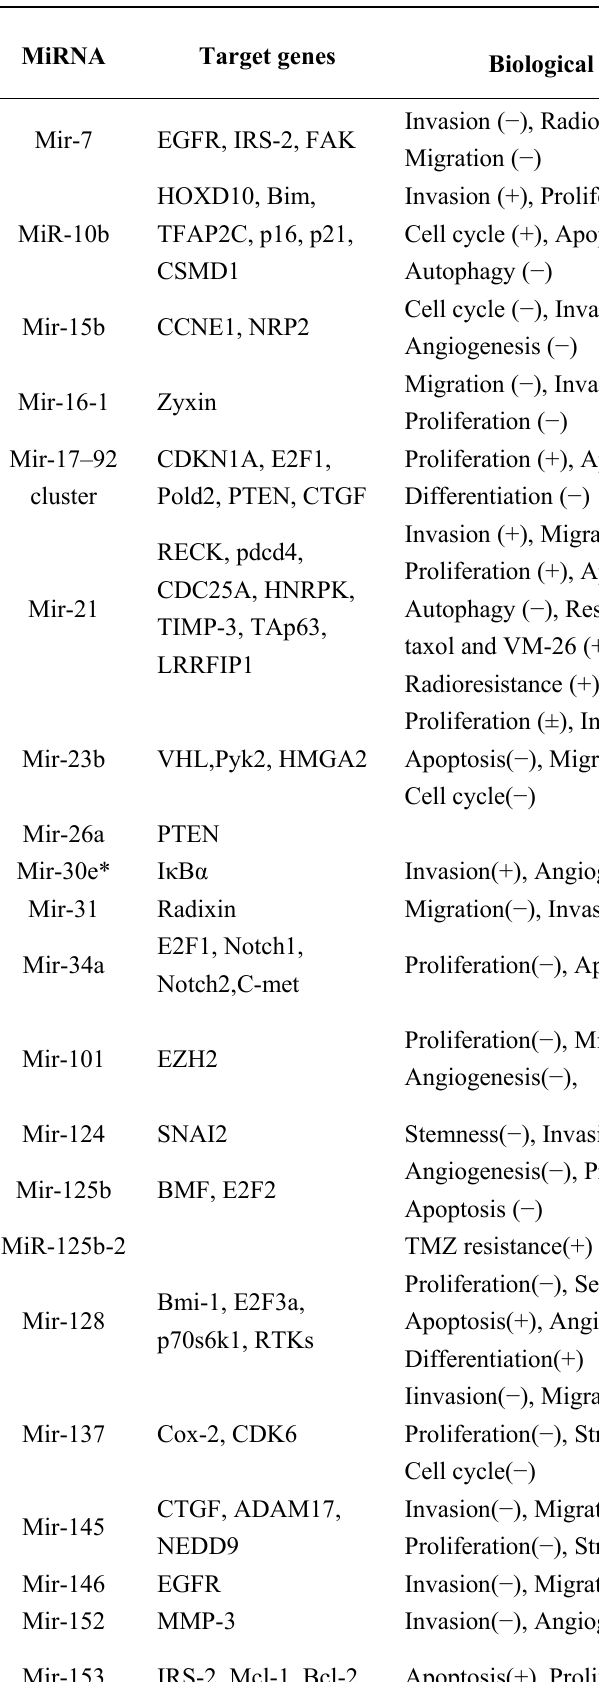
Table 1. MiRNA biological functions in